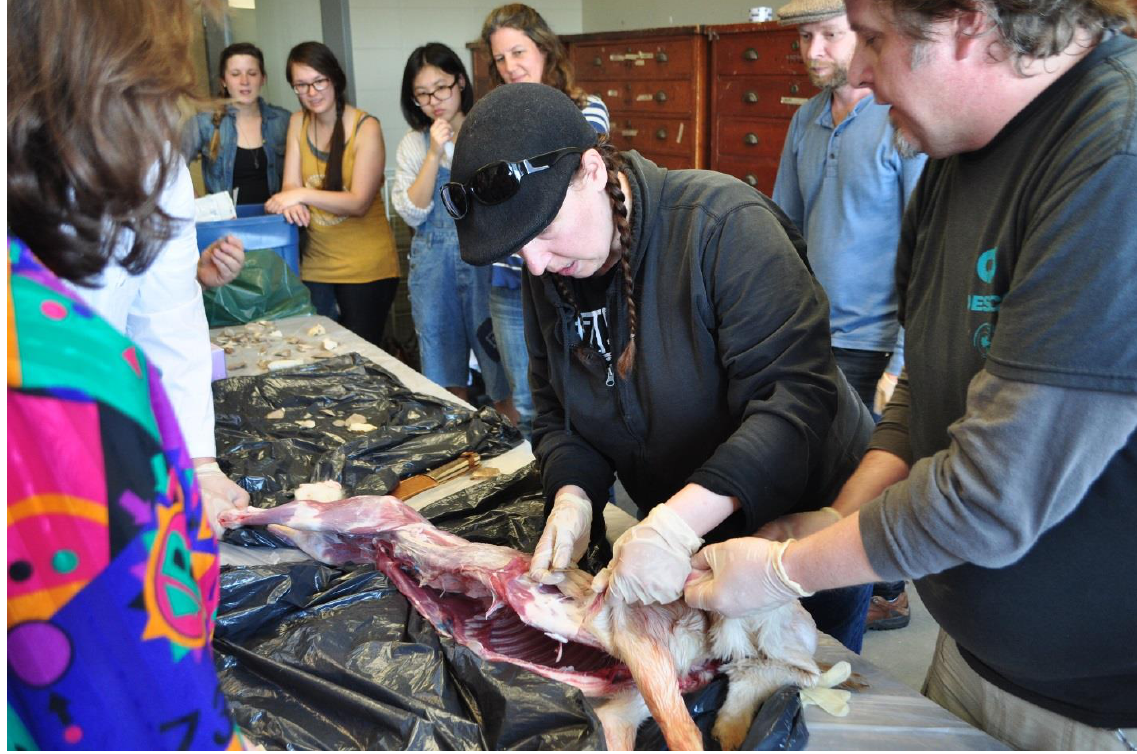
Figure 3. Skinning the goat with the knapped flakes. (Photo by Paulina